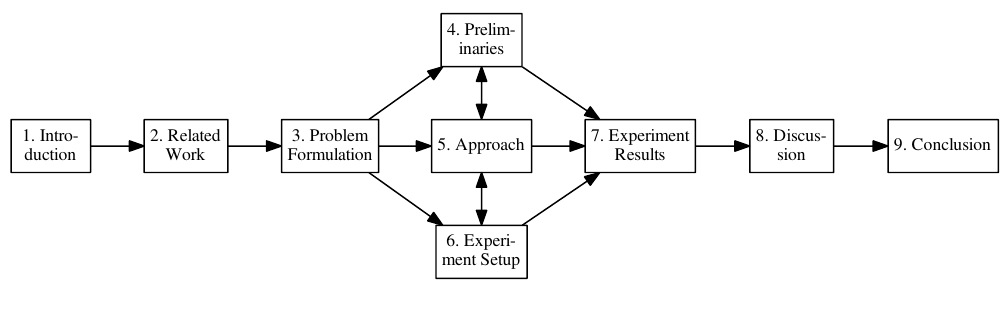
Figure 1. Road-map of the organization of the